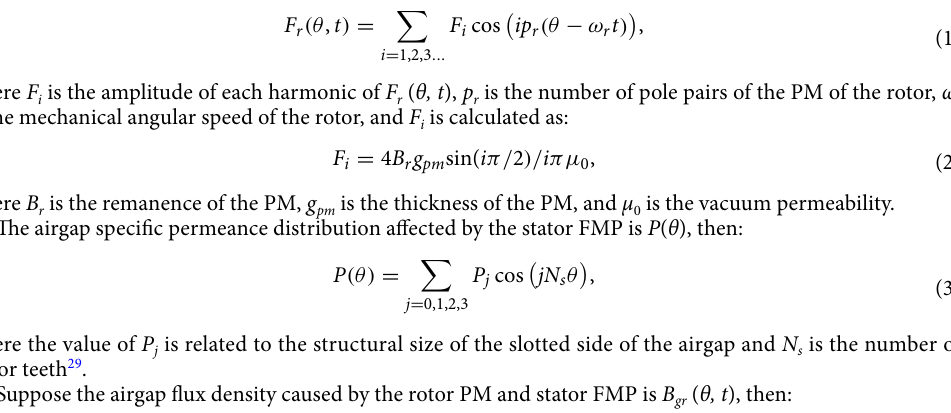
where the value of P j is related to the structural size of the slotted side of the airgap and N s is the number of stator teeth 29 .